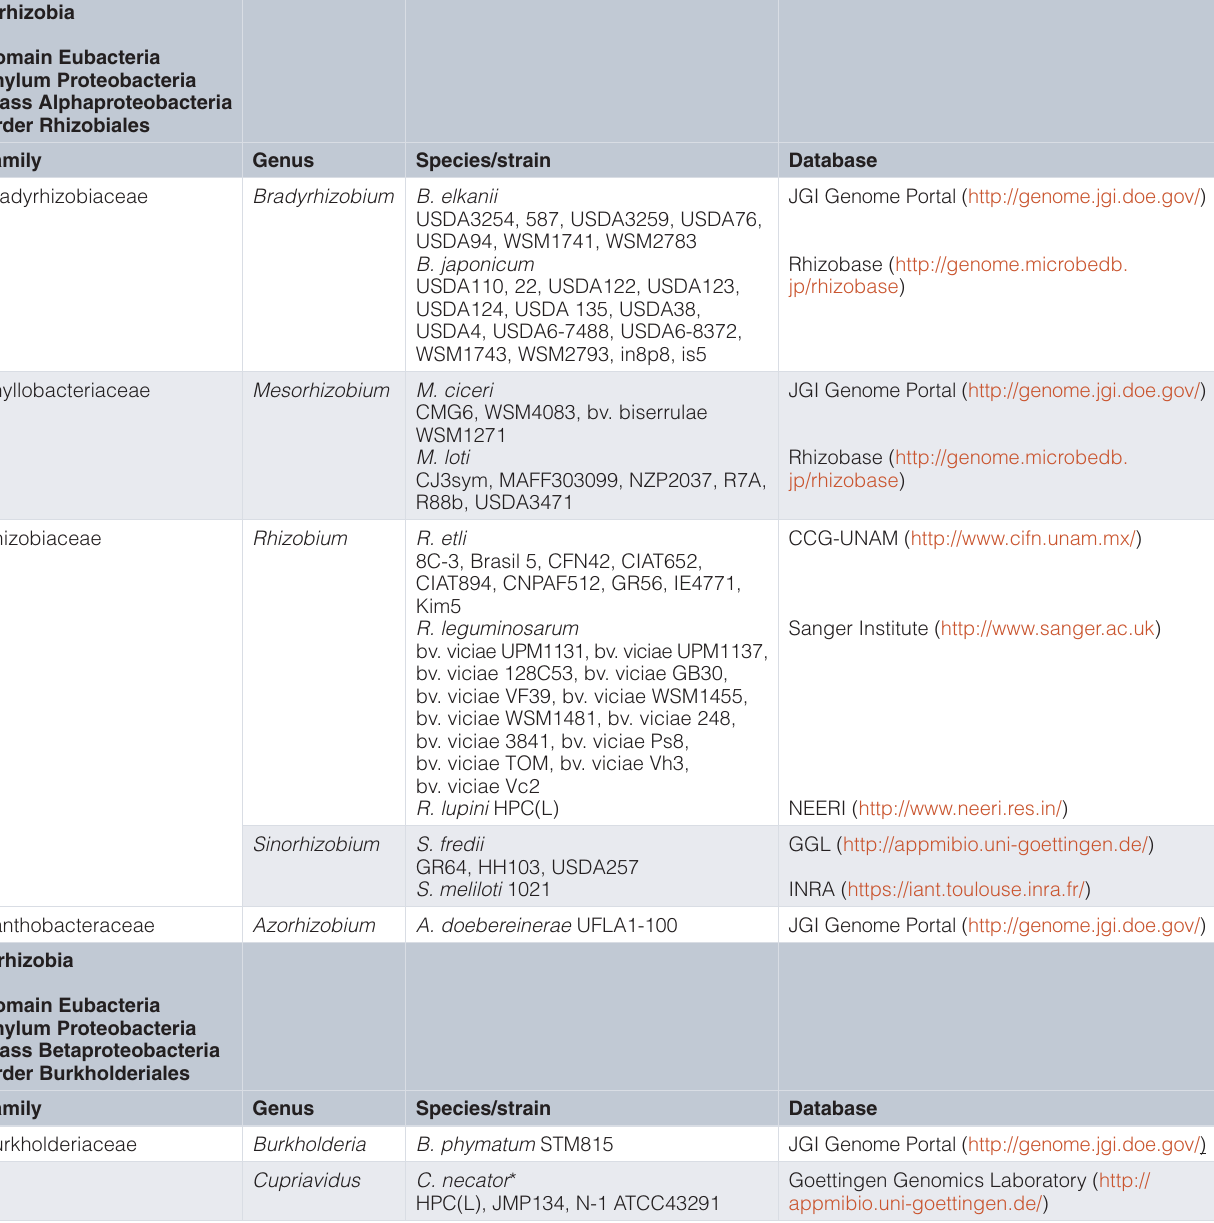
Table S1. Classification of the α - and β -rhizobia and rhizobial genomes analyzed in this work. α